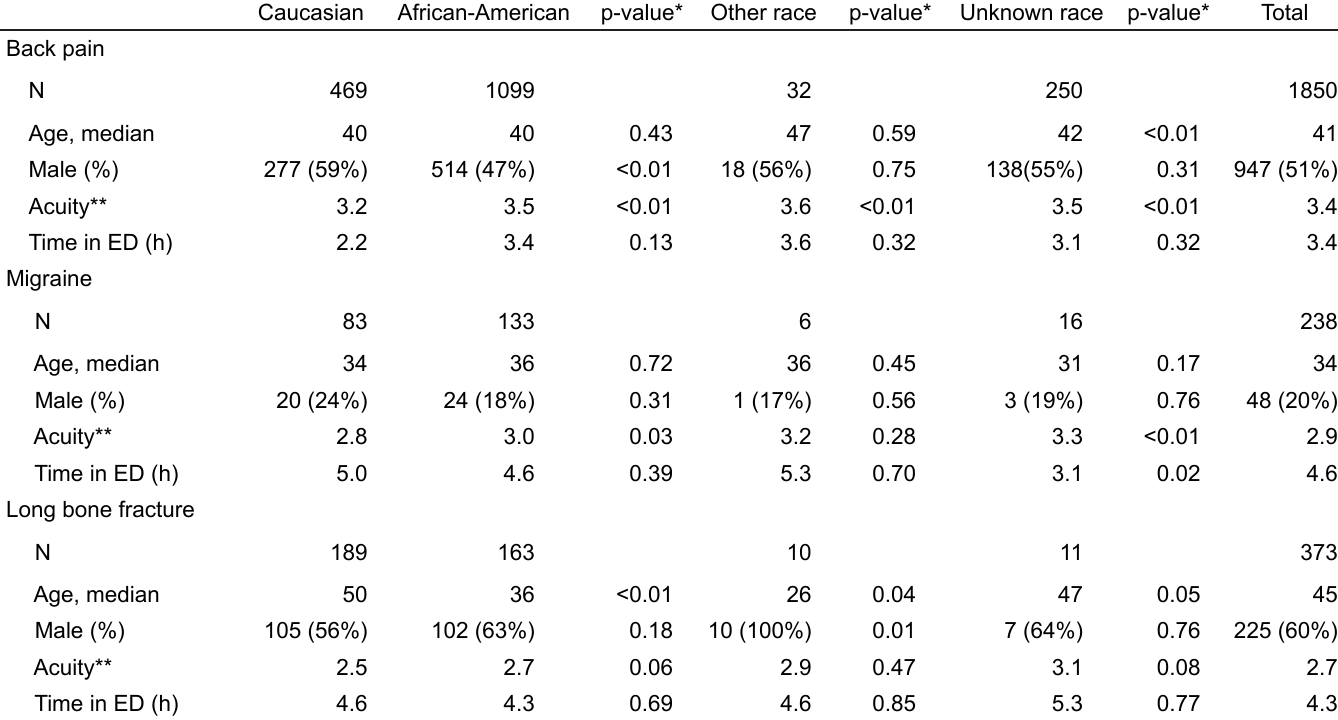
Table 2. Baseline characteristics of study population by diagnosis, 2007-2011, N=2,461.